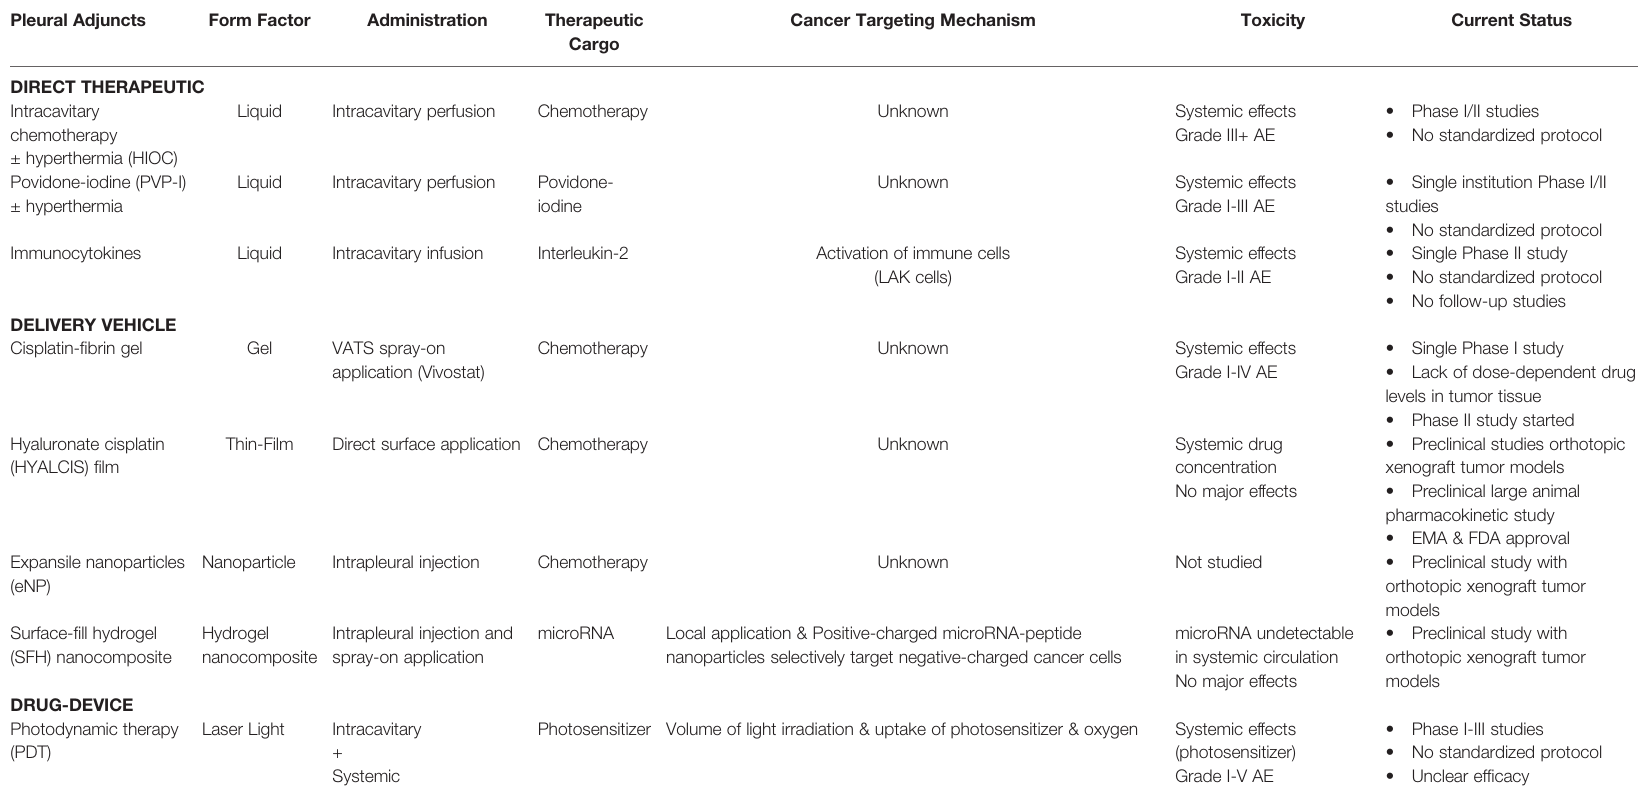
TABLE 1 | Locoregional pleural-directed adjuncts against mesothelioma: pros &